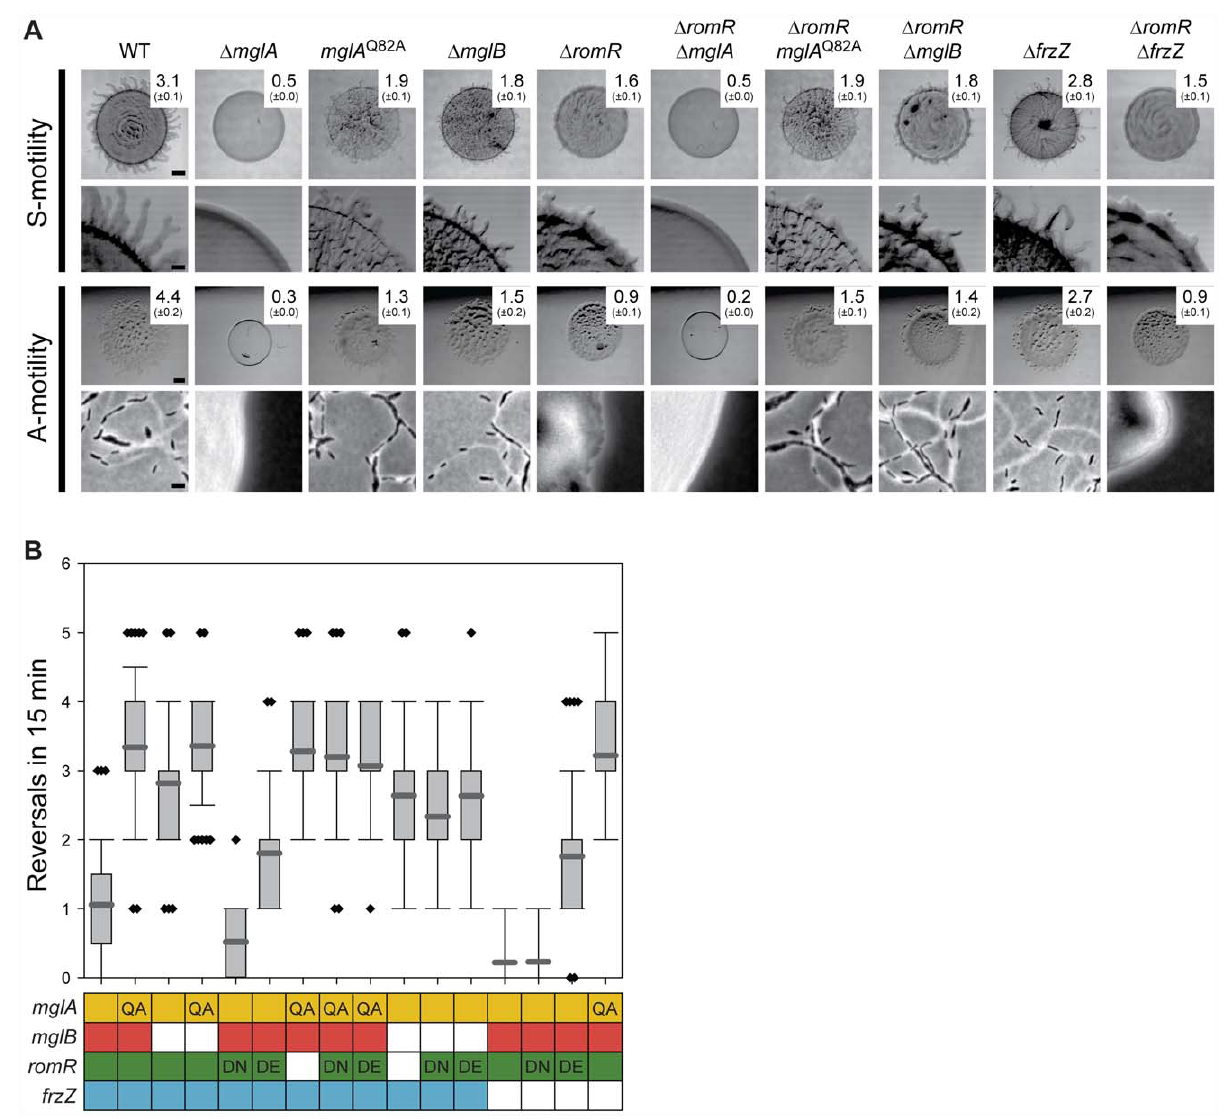
Figure 3. RomR acts upstream of MglA and MglB and downstream of FrzZ. (A) Motility phenotypes of strains of the indicated genotypes. The WT and D romR images from Figure 1 are included for comparison. Note that hyper- or hypo-reversing mutants expand less than WT colonies due to the abnormal reversal frequency and not due to defects in A- and S-motility [26,28]. The indicated strains were incubated at 32 u C for 24 h on 0.5% agar/0.5% CTT medium and 1.5% agar/0.5% CTT medium to score S- and A-motility, respectively. Motility is evaluated as described in Figure 1A. Scale bars, 1 mm, 200 m m, 1 mm, and 5 m m from top to bottom row. (B) Box plot of reversal frequencies measured in the strains of the indicated genotypes. The boxes below indicate alleles present: Colored, WT; white, in-frame deletion; QA, DN and DE: MglA Q82A , RomR D53N and RomR D53E . n . 50. Cells were transferred from a liquid culture to a thin agar pad, covered with a coverslip and followed by time-lapse microscopy in which cells were imaged at 30-s intervals for 15 min. For each strain, 50 cells were followed. In the box plot, the Y-axis is number of reversals per 15 min, boxes enclose the 25 th and 75 th percentile with the dark grey line represents the mean, whiskers represent the 10 th and 90 th percentile, and diamonds